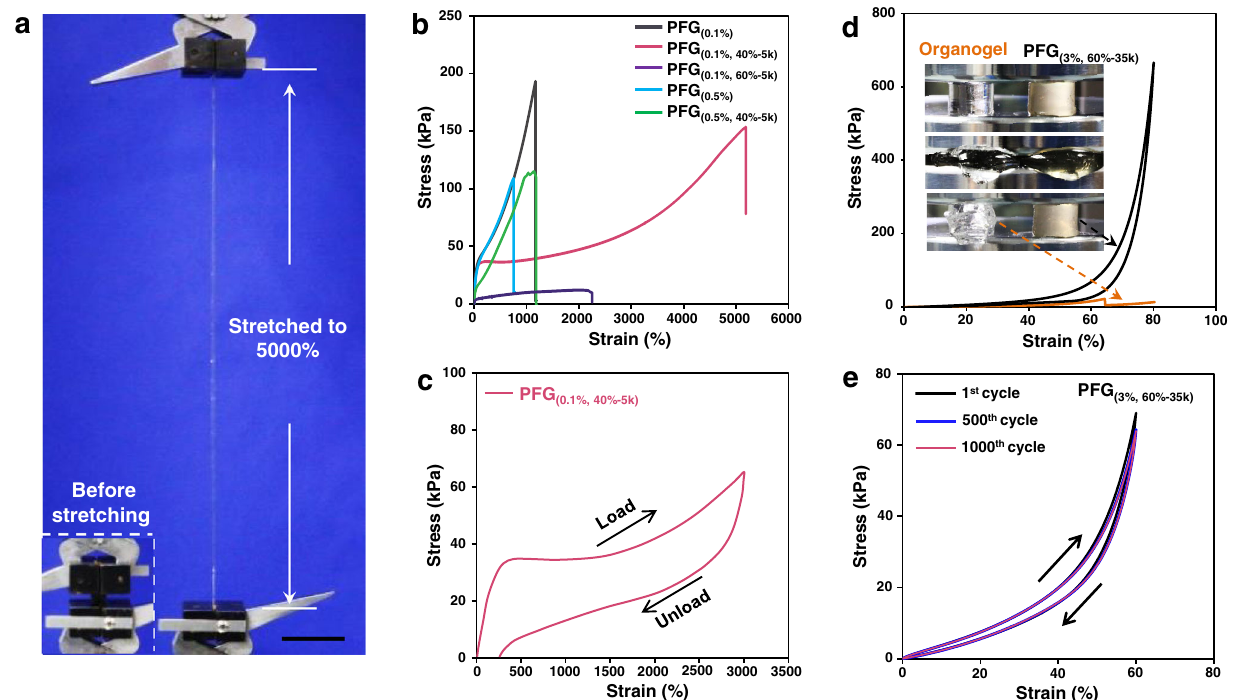
Fig. 2 Mechanical properties of polymer- fl uid-gels (PFGs). a Photographs of the PFG (0.1%, 40%-5k) before and after stretching to 5000%. Scale bars: 5 mm. b Tensile stress – strain curves of the PFGs. c Cycle tensile of the PFG (0.1%, 40%-5k) (up to 3000% strain). d Compressive stress – strain curves of the PFG (3%, 60%-35k) and the poly (n-butyl acrylate) (PBA) organogel. e Cyclic stress – strain curves of the PFG (3%, 60%-35k) compressed to 60% strain and released for 1000